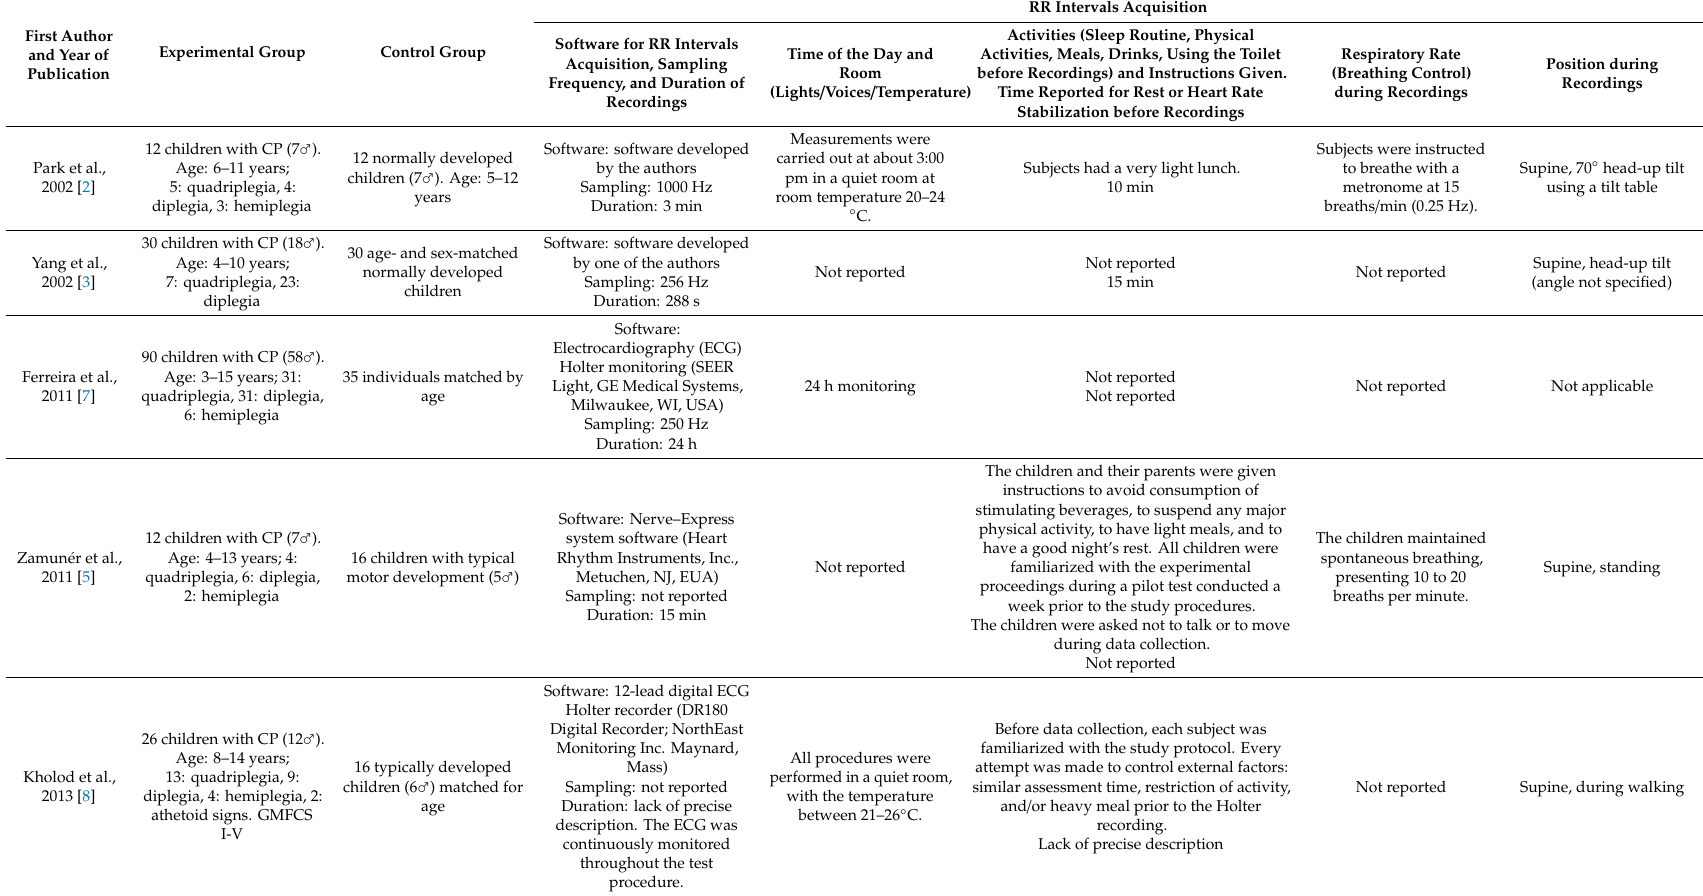
Table 1. Baseline characteristics of study participants and details concerning RR interval